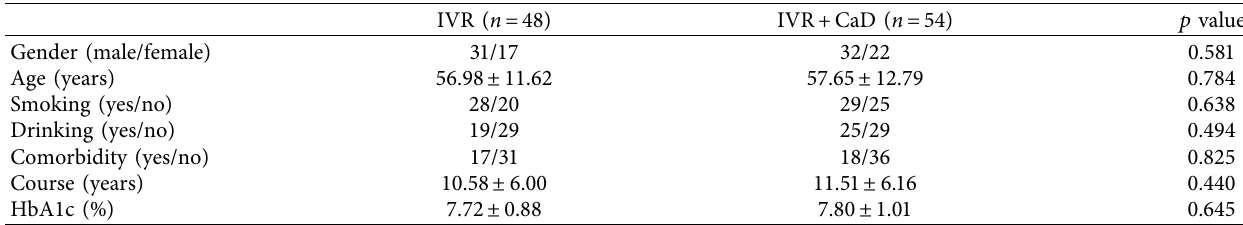
Figure 1: Flowchart of patient selection. Table 1: Baseline characteristics of total study population.